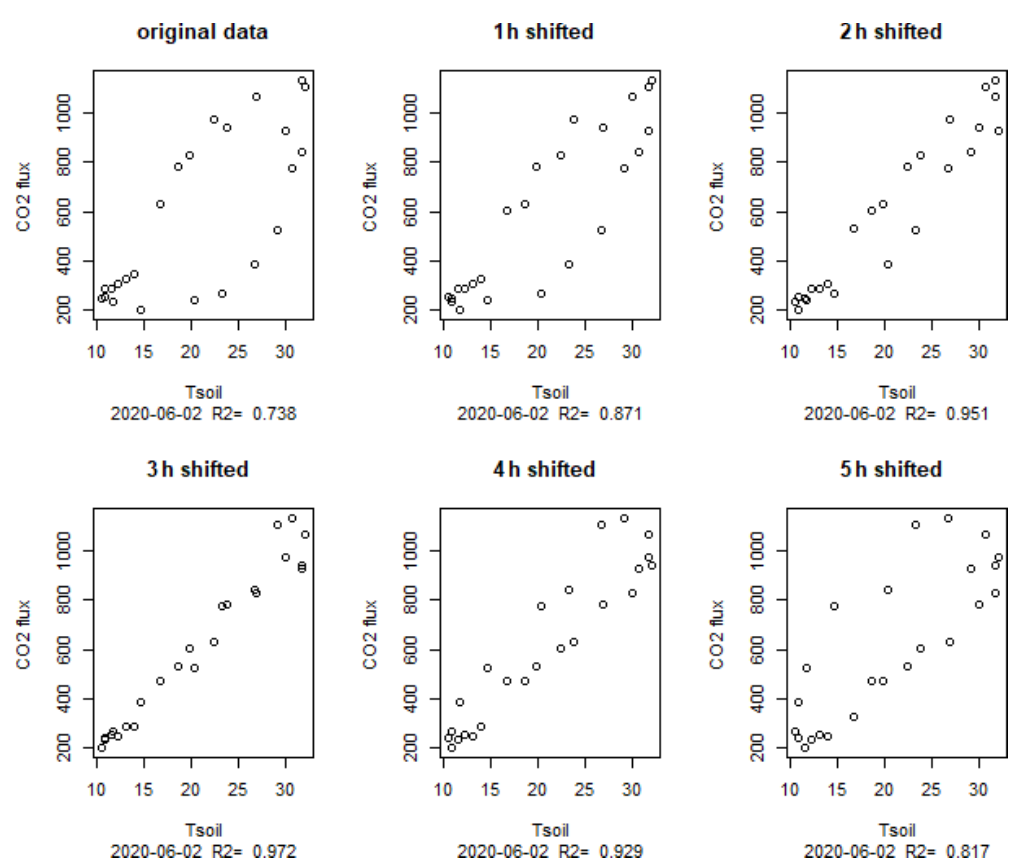
Figure 8. Hysteresis loop for 2 June (same data as in Fig. 3b) with flux data shifted for various hours; 3h shifted means that the flux at 10:00 local time (CEST) was correlated with the temperature at